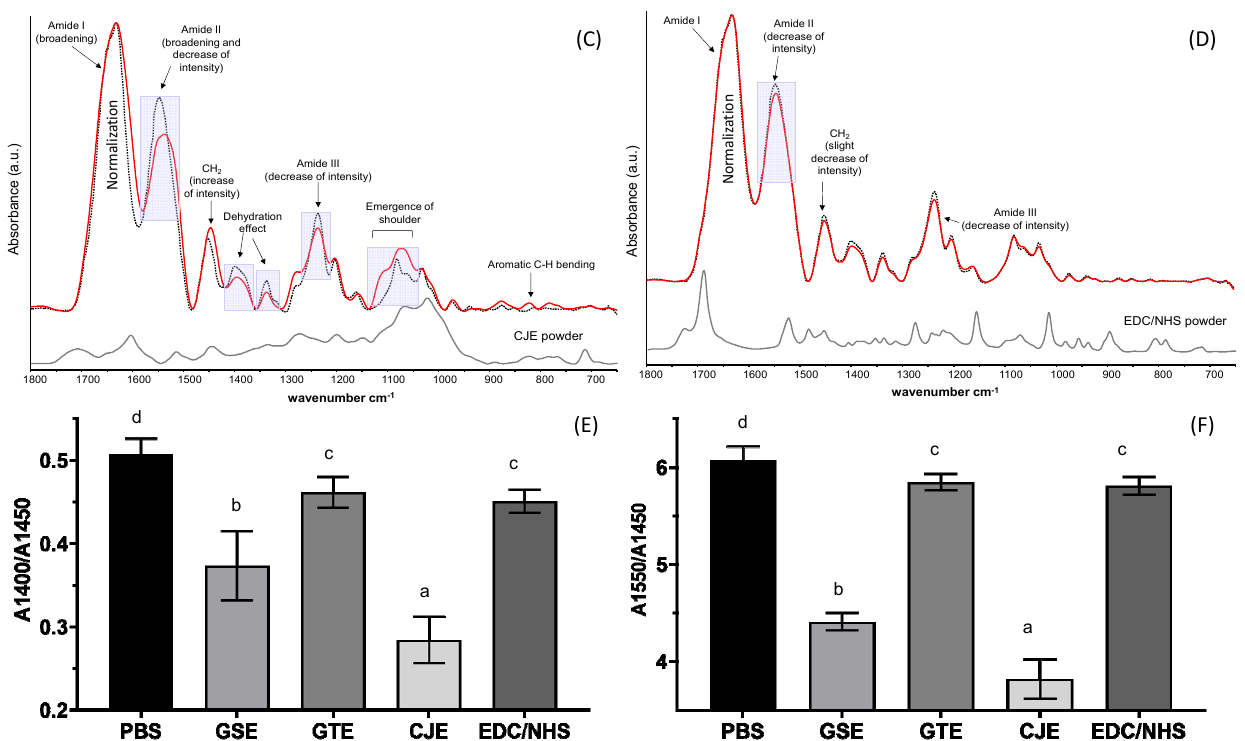
Figure 1. Representative FTIR spectra of dentin collagen before (black dotted line) and after cross-linker treatment (solid red line) for 30 s, as well as cross-linker powders (solid black line). ( A ) Treated with GSE, ( B ) treated with GTE, ( C ) treated with CJE, and ( D ) treated with EDC/NHS. The untreated and treated collagen spectra were normalized based on the intensity of amide I peak ( A – D ). Spectral changes and peak assignments were labeled with more obvious changes that are highlighted in the shaded rectangular areas. ( E ) Peak ratios of C-O and C-N bending to CH 2 (A1400/A1450) and ( F ) peak ratios of amide II to CH 2 (A1550/A1450). Means with different letters are significantly different ( p < 0.05). PBS: phosphate buffered saline. GSE: grape seed extract. GTE: green tea extract. CJE: cranberry juice extract. EDC/NHS: carbodiimide/n- hydroxysuccinimide.